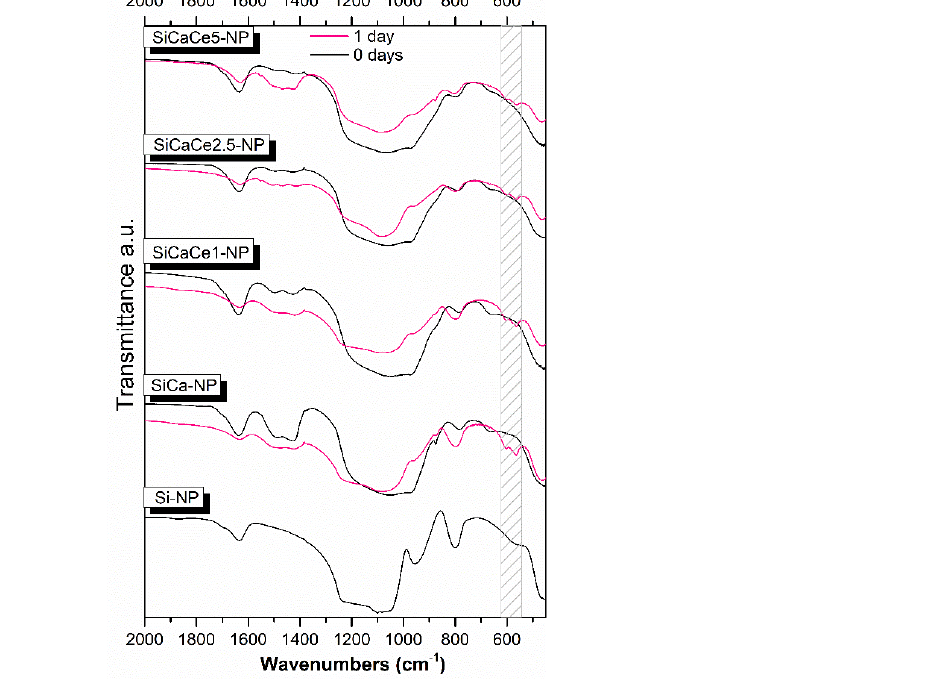
Figure 5. FTIR spectra of all NPs before (0 days) and after (1 day) immersion in simulated body fluid (c-SBF).